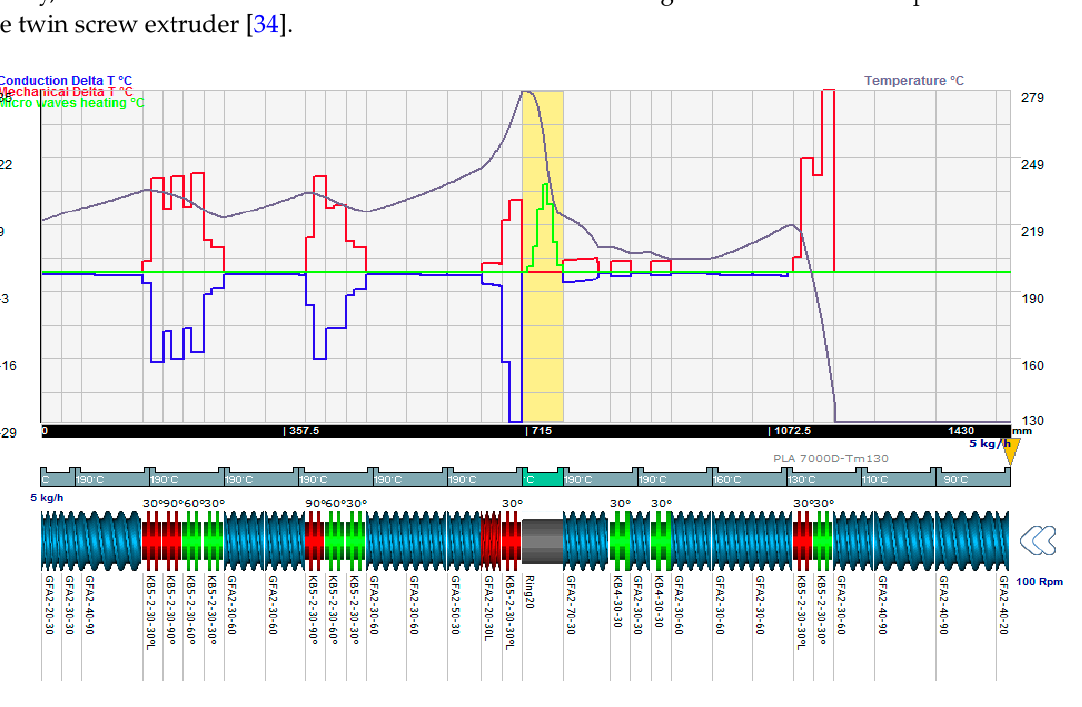
Figure 4. Temperature variation due to conduction ( purple ), due to mechanical effect ( red ) and micro-wave (AE) (100 W) ( green ) effect and result on final temperature ( grey ).